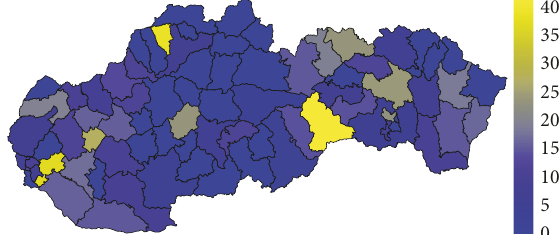
Figure 6: The standardised mortality rate of the male sex in the individual districts of the Slovak Republic in